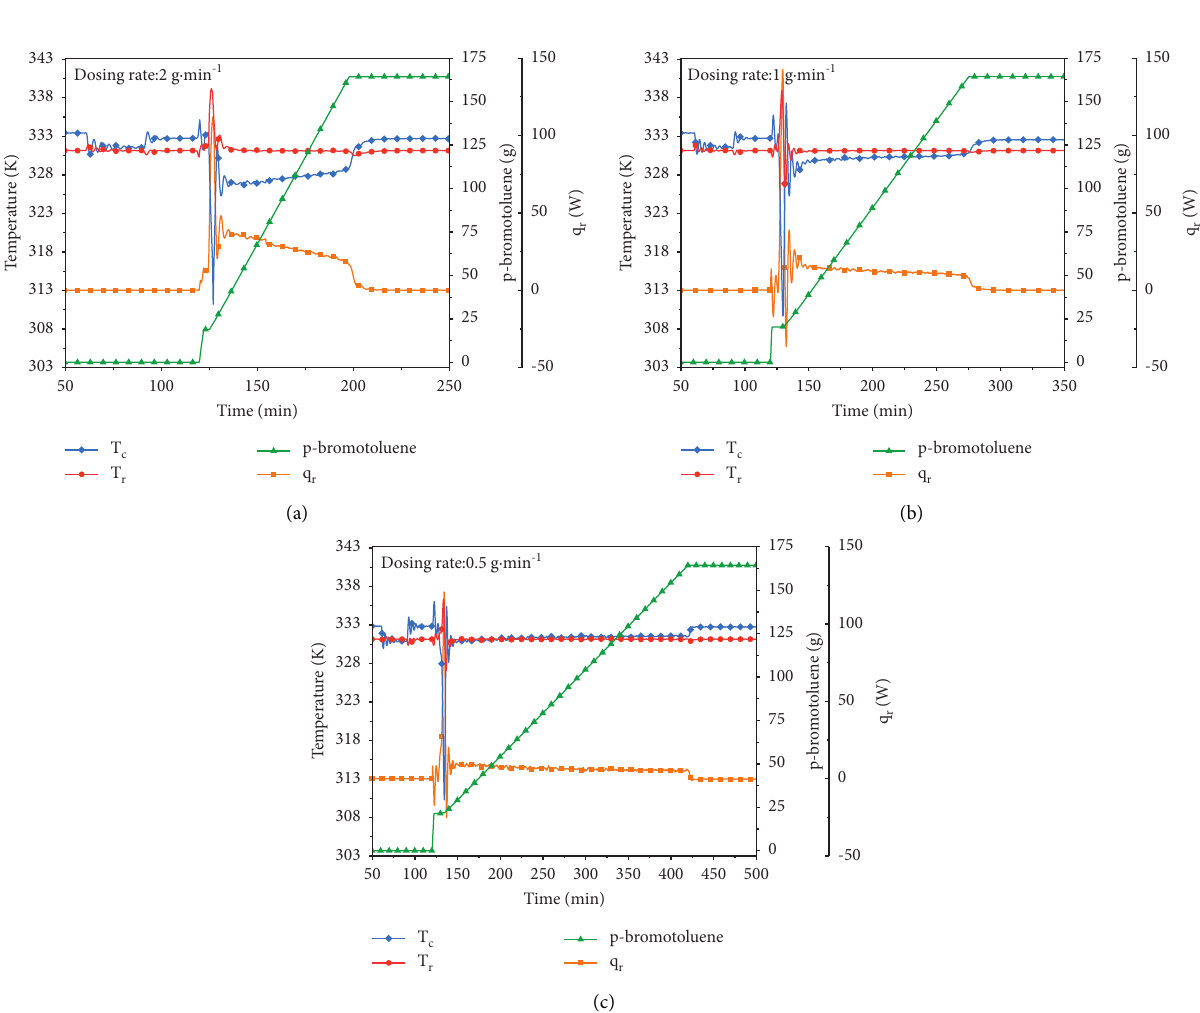
Figure 4: T c , T r , q r , and p -bromotoluene dosing curves for synthesis of Grignard reagent at different dosing rates. (a) Dosing rate of 2.0g · min − 1 . (b) Dosing rate of 1.0 g · min − 1 . (c) Dosing rate of 0.5 g · min − 1 .